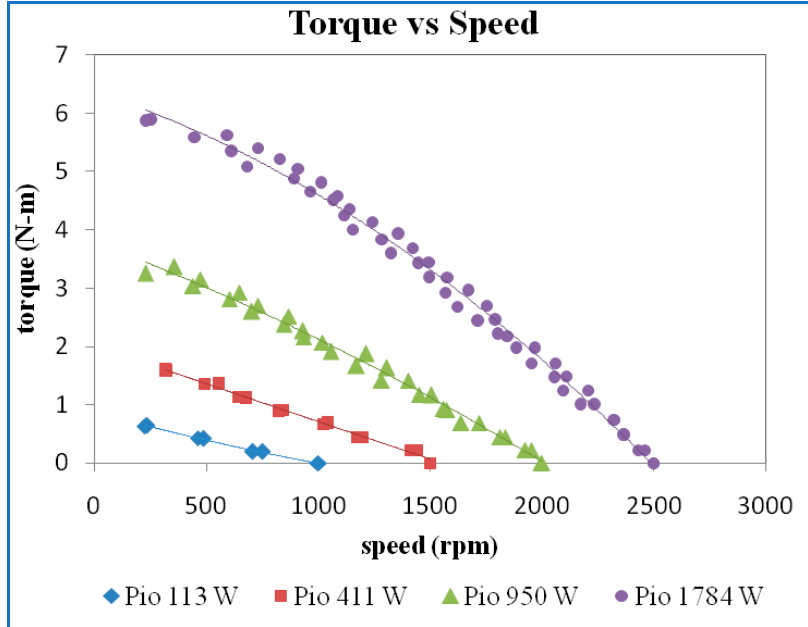
Figure 17. Torque vs. speed at a guide vane opening of 16 mm.